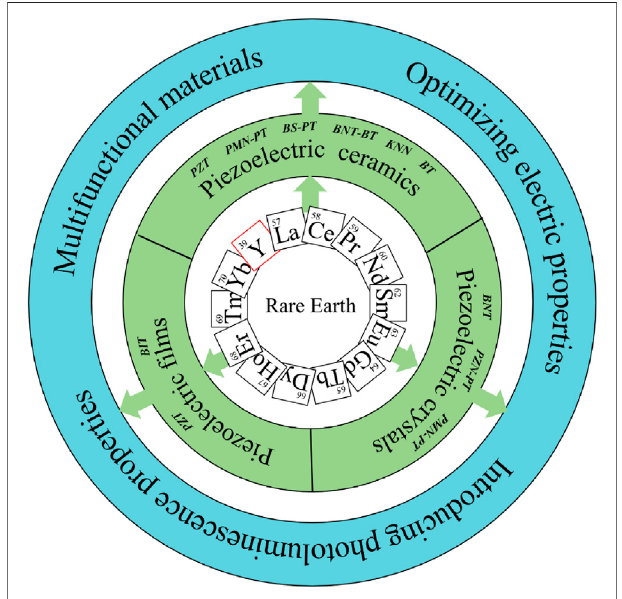
FIGURE1| Relationship betweentherare Earth, piezoelectricmaterials, and properties.